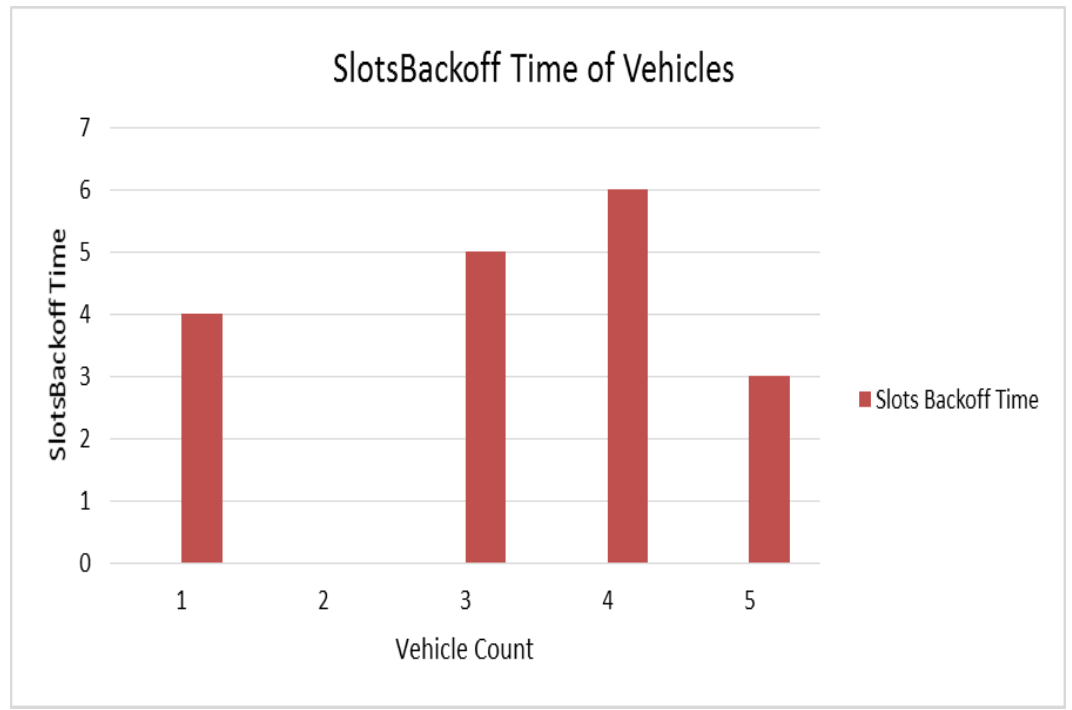
Figure 17. Slots Backoff Time of